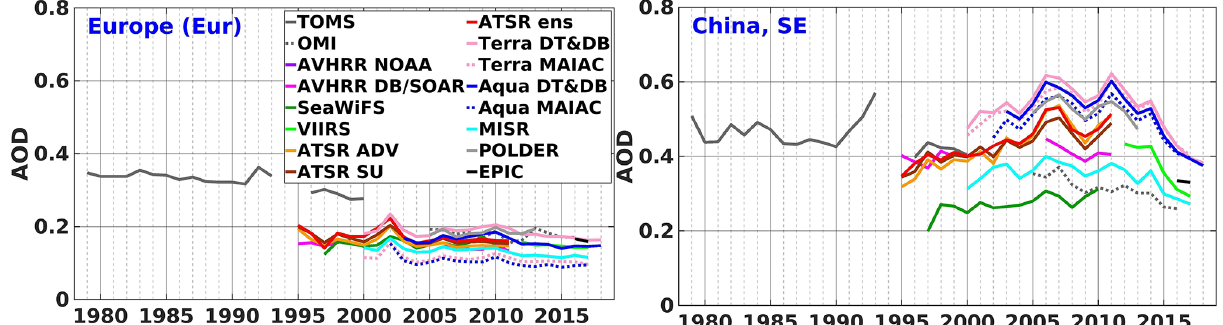
Figure 4. Annual AOD time series from different products (see legend) for Europe and ChinaSE. For all selected regions see Fig.